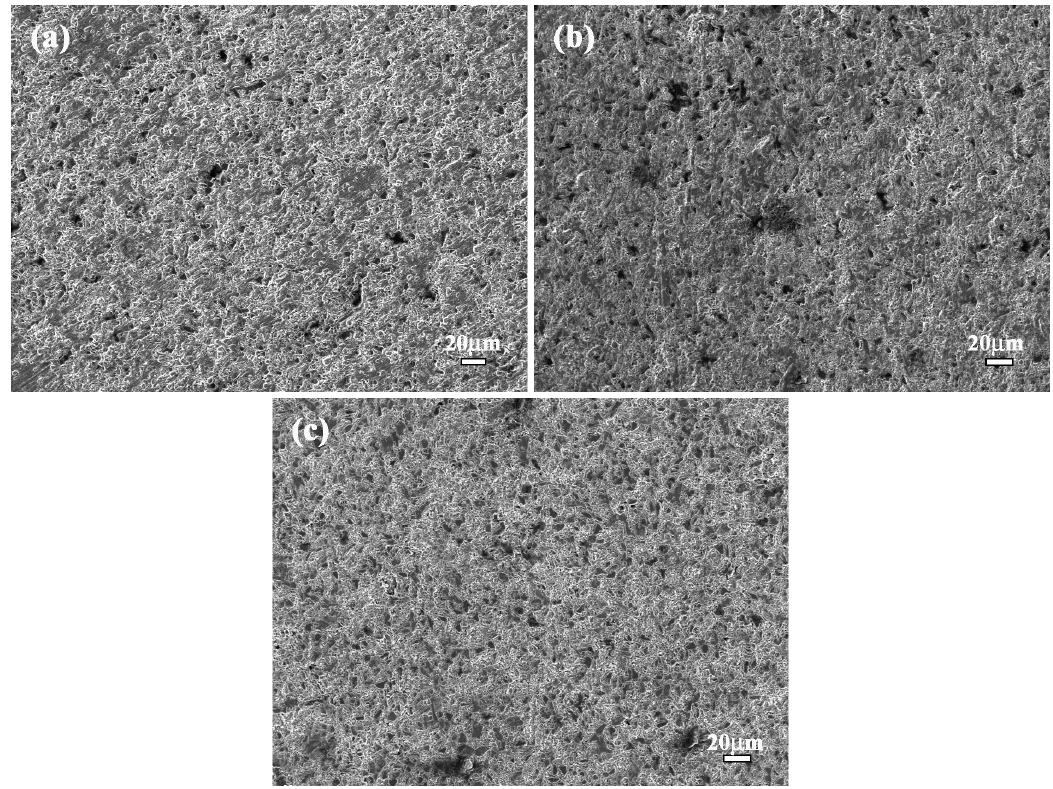
Figure 1. Compactness of B 4 C/Al 5083 composite with ( a ) 10 wt % B 4 C content; ( b ) 20 wt % B 4 C content; ( c ) 30 wt % B 4 C content.